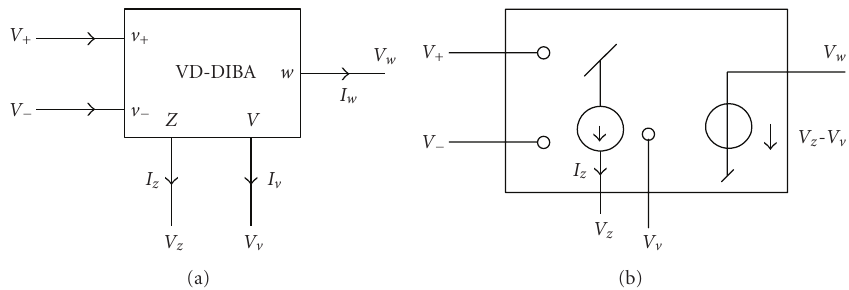
Figure 1: (a) Schematic symbol and (b) equivalent model of VD-DIBA [26].